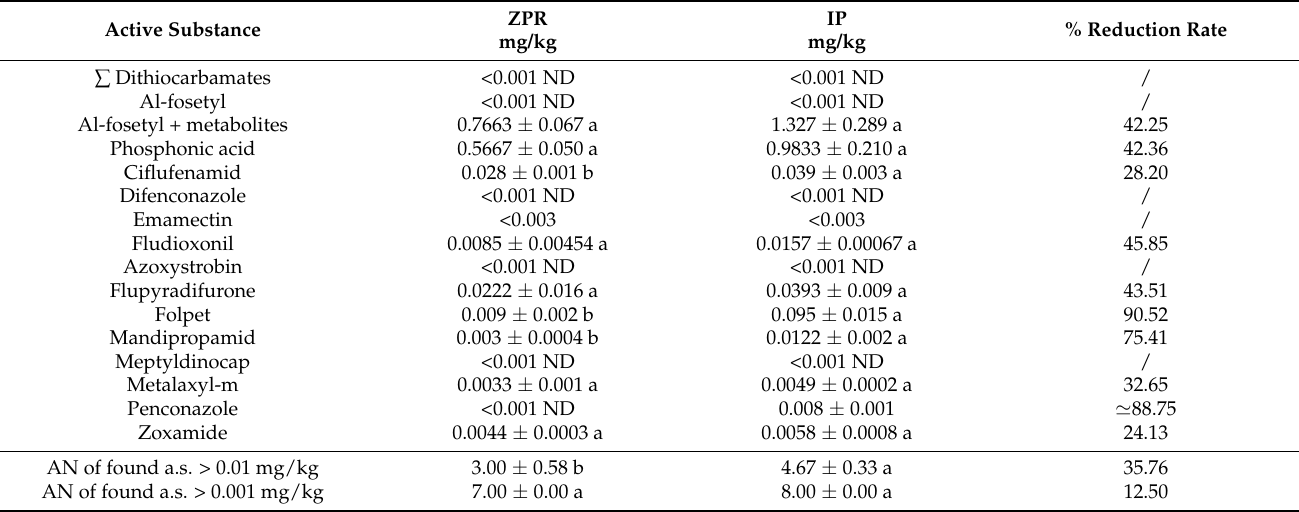
Table 8. Average concentration (mean ± SE) of pesticide residues in Rebula grapes. A result of <0.001 ND means that a.s. was not detected at a level higher than 0.001 mg kg − 1 . /—concentration reduction rate and significance of difference between IP (integrated) and ZPR (0-pesticide residue) means cannot be calculated. Pesticide concentration reduction rate (%) = 100 − ((ZPR/IP) × 100) (see explanation in Section